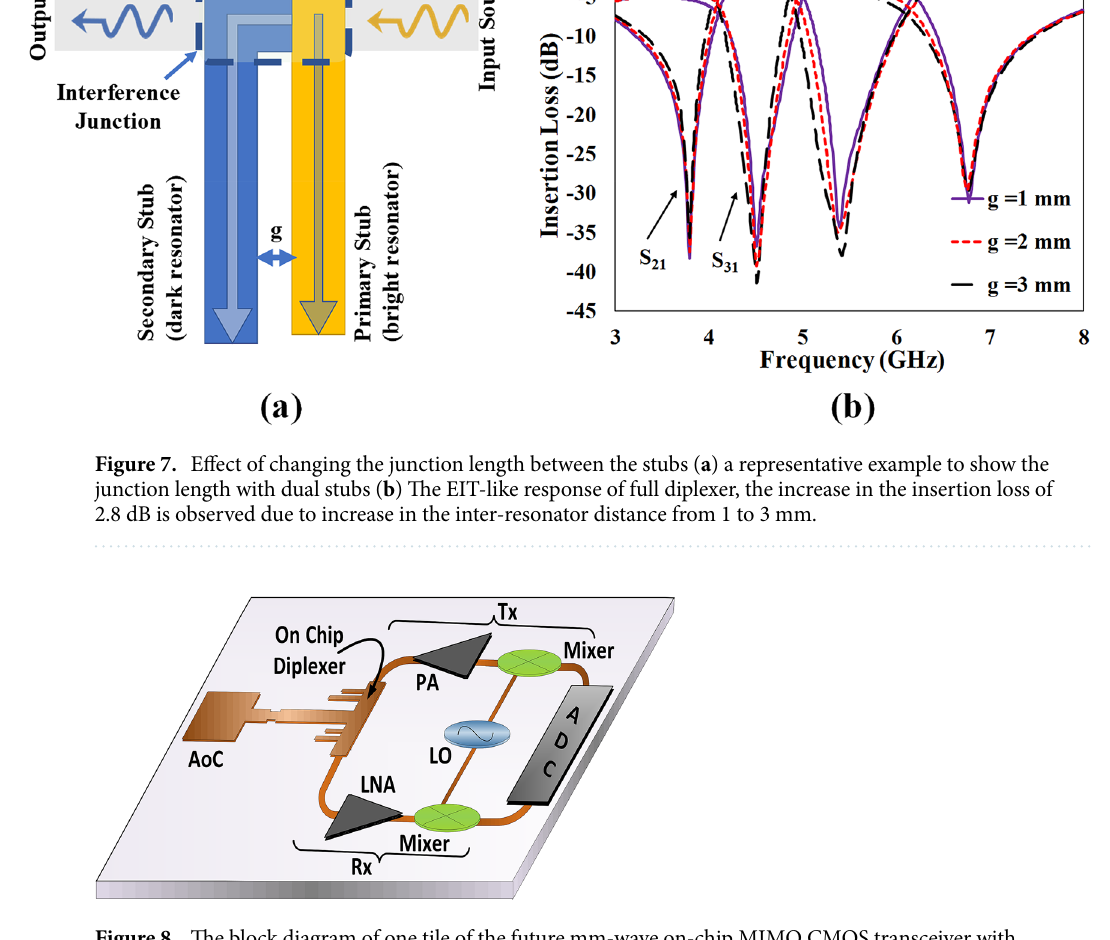
Figure 8. The block diagram of one tile of the future mm-wave on-chip MIMO CMOS transceiver with integrated on-chip antenna (AoC) and proposed diplexer circuit for frequency division duplex (FDD)